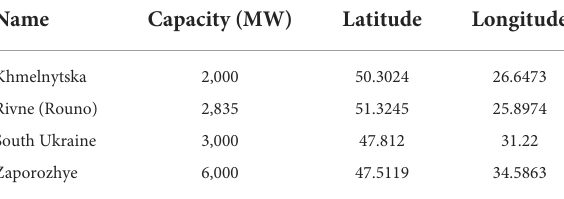
TABLE 1 Name, capacity, and coordinates of the Ukrainian nuclear power